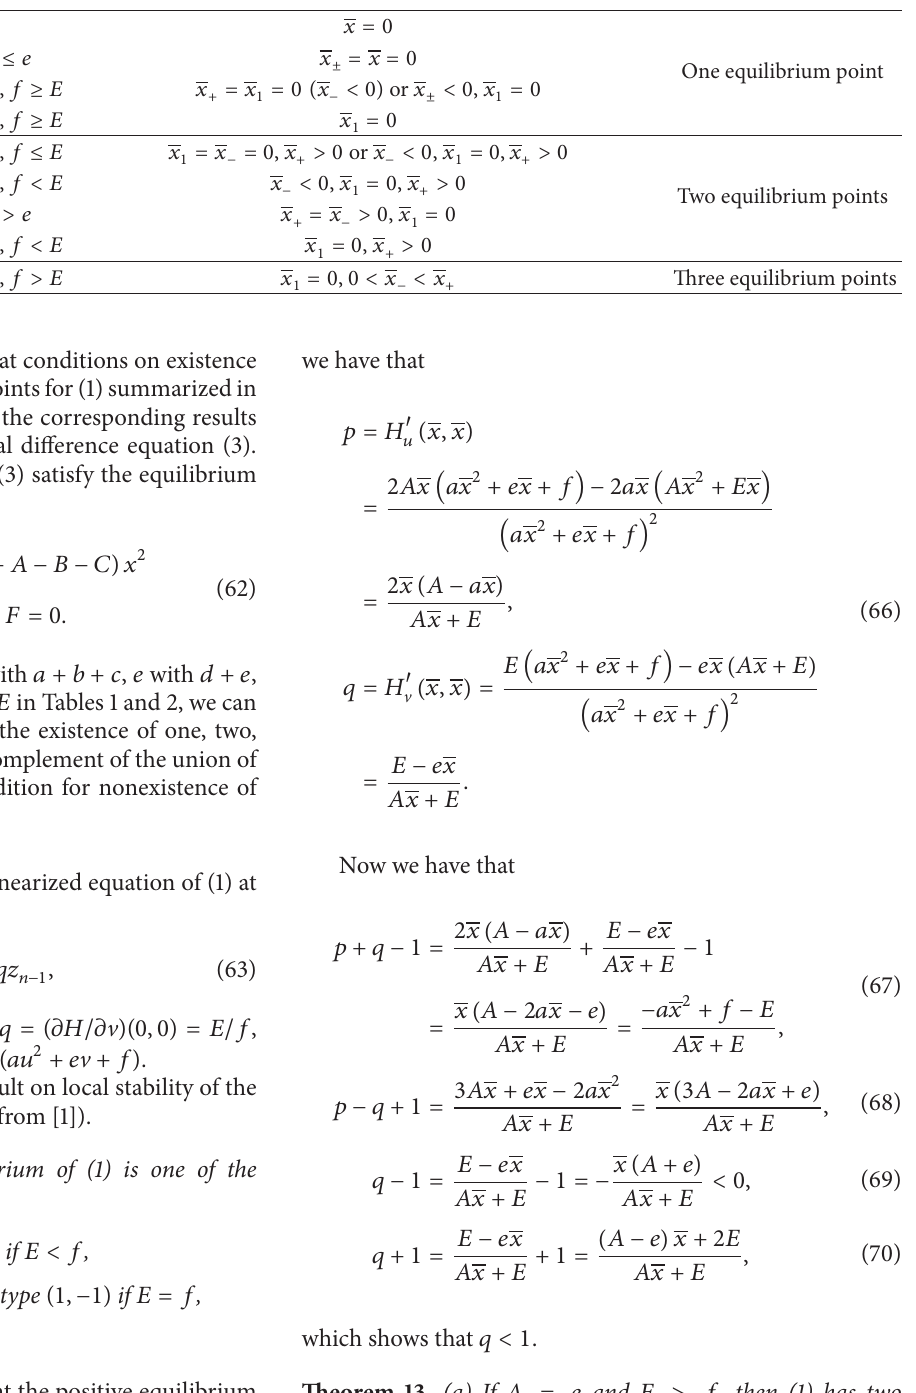
Table 2: Existence of the equilibrium points of (1) when 𝐹 = 0